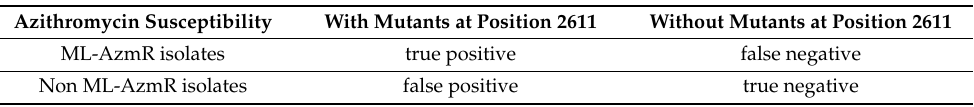
Table 1. Summary of different variables for the meta-analysis of the diagnostic test. ML-AzmR, moderate-level